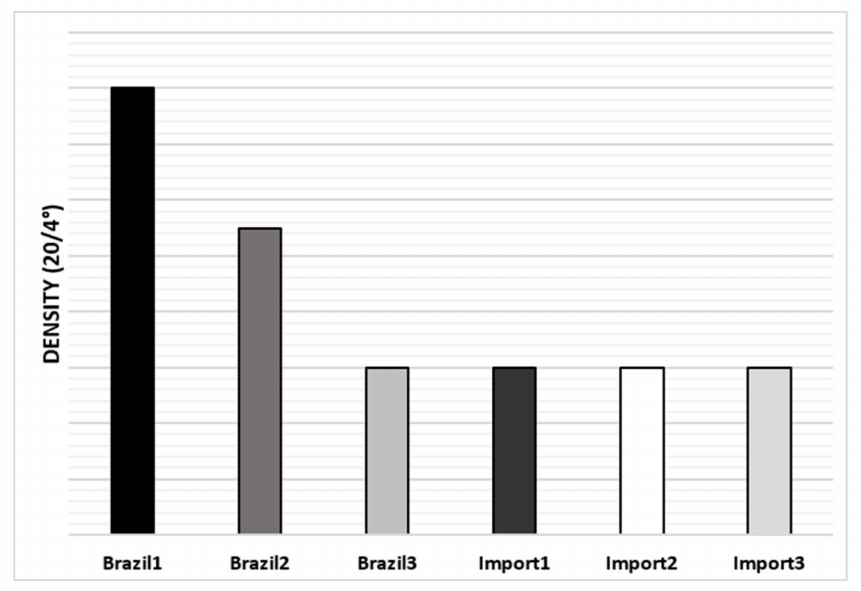
Figure 5. The average density of naphtha’s